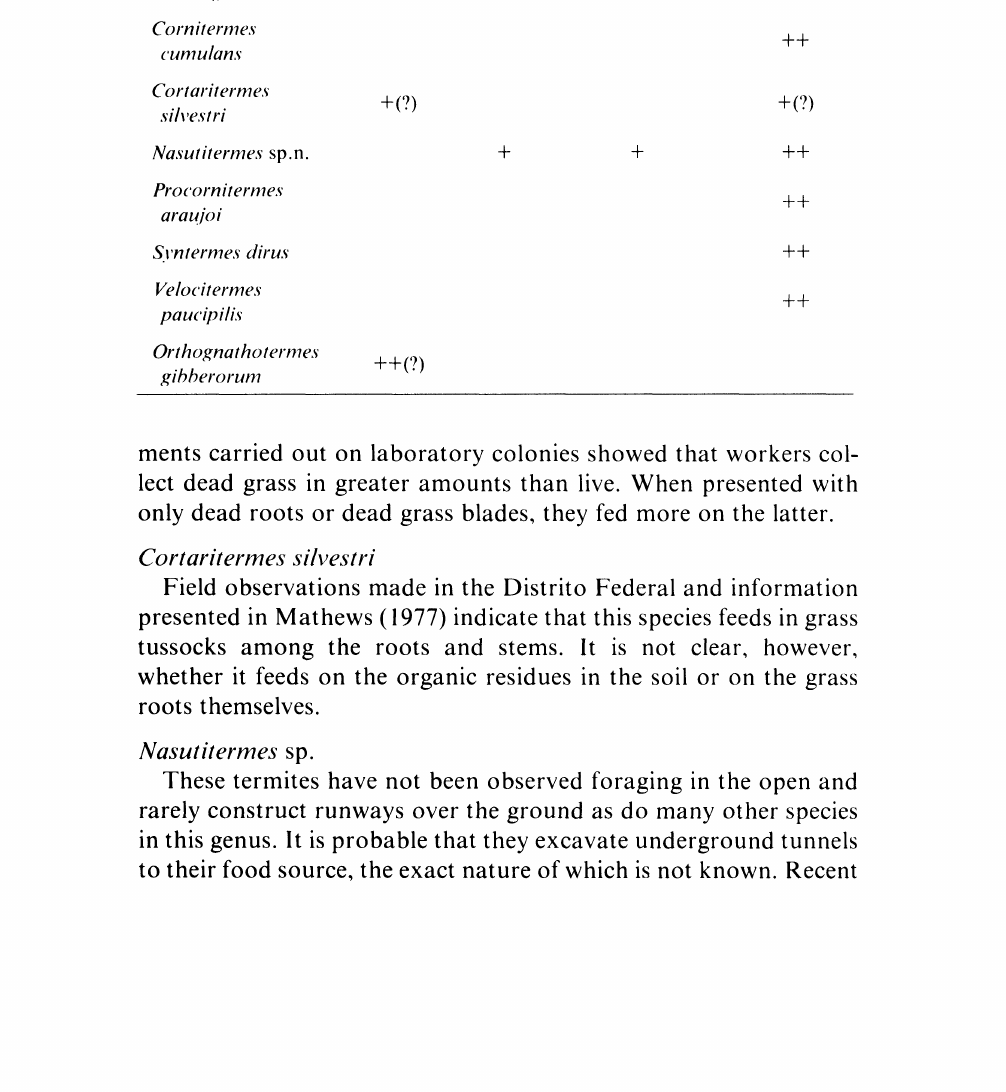
Negret & Redford Termite Species 99 Table 7. Modal feeding habits (++ commonly consumed; + occasionally consumed). SPECIES FOOD SOURCE Grass & Sdund Decomposin Her#aceous Humus Wood Wood